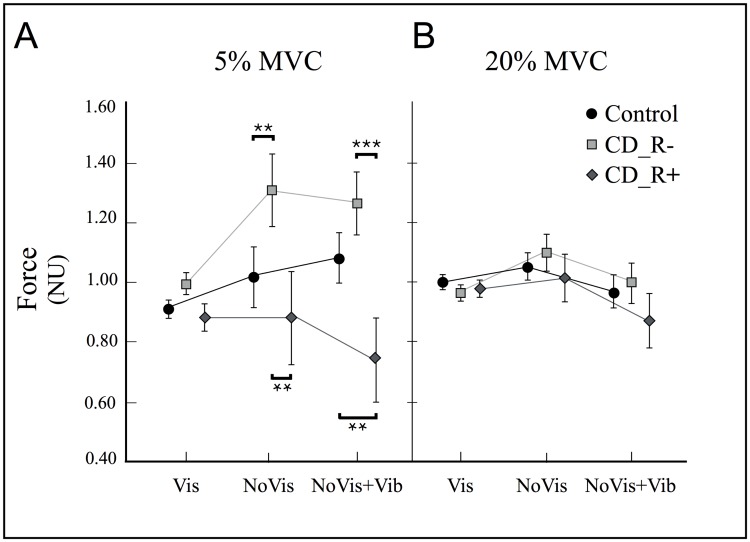
Group performance in the visuomotor force-matching task.Mean force (mean±SD) for the three groups during condition_Vis, condition_NoVis and condition_NoVis+Vib at 5% MVC (A) and at 20% MVC (B). (A) No significant difference in mean force between groups in condition_Vis. Significant differences at 5% MVC during condition_NoVis between CD_R- and control subjects (p = 0.006), and also between CD_R- and CD_R+ patients (p = 0.002). Note that the variability of mean force (SD) increased about 5-fold in all three groups. Significant differences during condition_NoVis+Vib between CD_R+ and control subjects (p = 0.006) and also between CD_R+ and CD_R- patients (p<0.001). (B) No difference in mean force at 20% MVC. * = p<0.05; ** = p<0.01; *** = p<0.001.